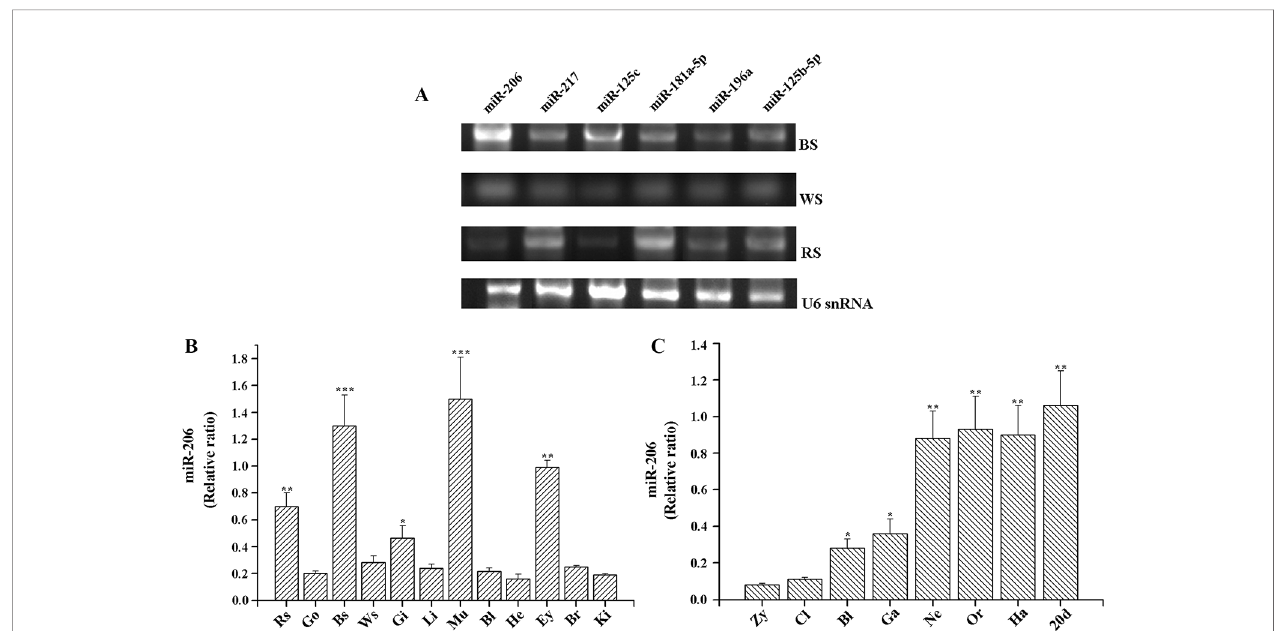
FIGURE 1 | Expression pro fi les of miRNAs in koi carp. (A) Expression patterns of six miRNAs in three skin color samples. MiRNA samples were extracted from the different tissues, including BS (black skin), WS (white skin), and RS (red skin). MiRNAs expression levels were detected by RT-PCR. U6 snRNA was detected as the loading control. (B) Expression patterns of miR-206 in different tissues. Rs, red skin; Go, gonad; Bs, black skin; Ws, white skin; Gi, gill; Li, liver; Mu, muscle; Bl, blood; He, heart; Ey, eye; Br, brain; Ki, kidney. (C) Overview of expression patterns during the early stages of koi carp. Zy, zygote; Cl, cleavage; Bl, blastula; Ga, gastrula; Ne, neurula; Or, organogenesis; Ha, hatching; 20 pdh, 20 days post-hatching. * p < 0.05, ** p < 0.01, *** p < 0.001.